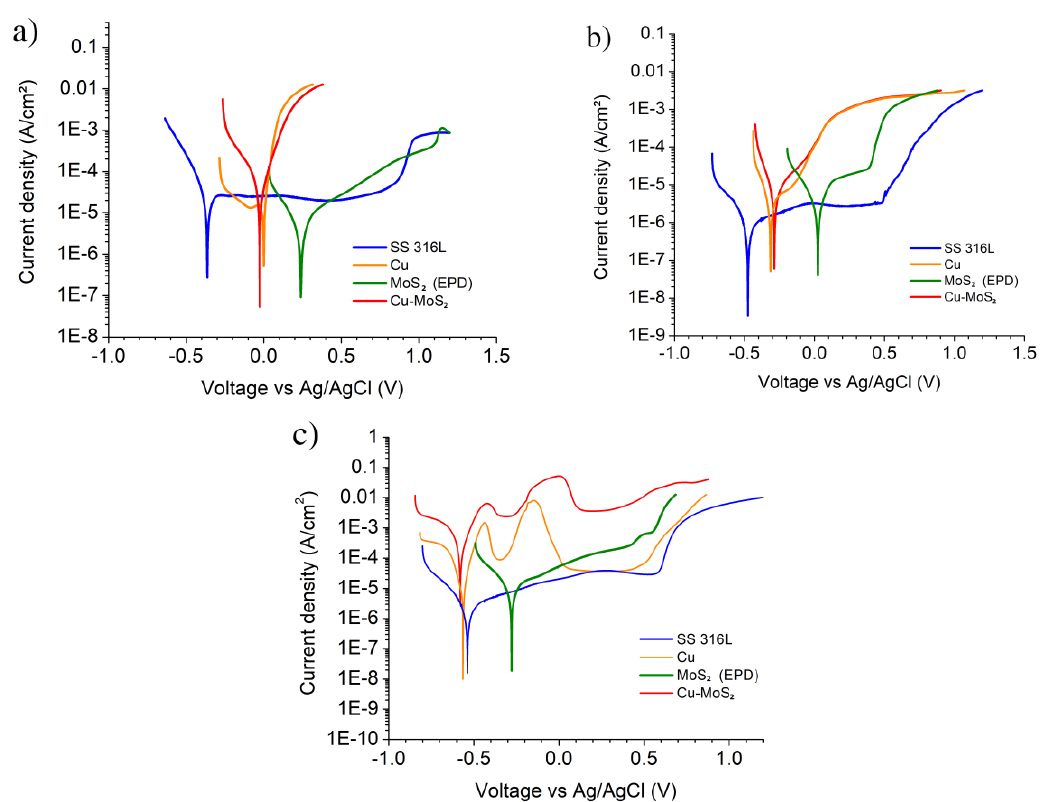
Figure 9. Potentiodynamic polarization of a bare SS 316L substrate, SS 316L coated by EPD with MoS 2 particles, a copper coated sample and a composite Cu–MoS 2 in ( a ) 0.1 M H 2 SO 4 , (b ) 0.1 M NaCl and ( c ) 0.1 M NaOH solution.